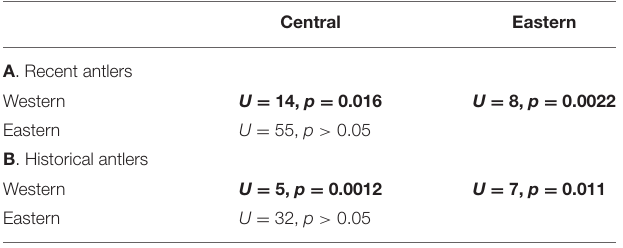
TABLE 3 | Pairwise Mann-Whitney U- tests among female antler 87 Sr/ 86 Sr in the Western, Central, and Eastern Coastal Plain. Central Eastern